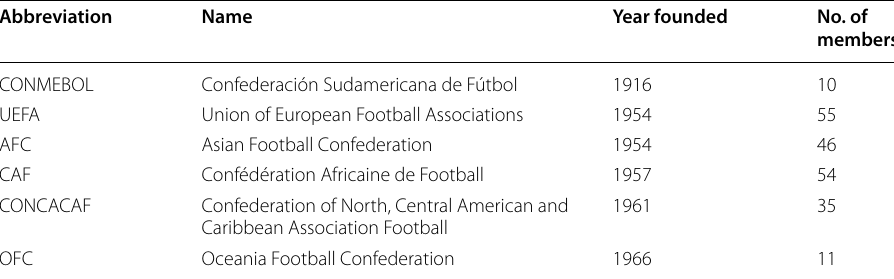
Table 1 Football confederations in FIFA (as of